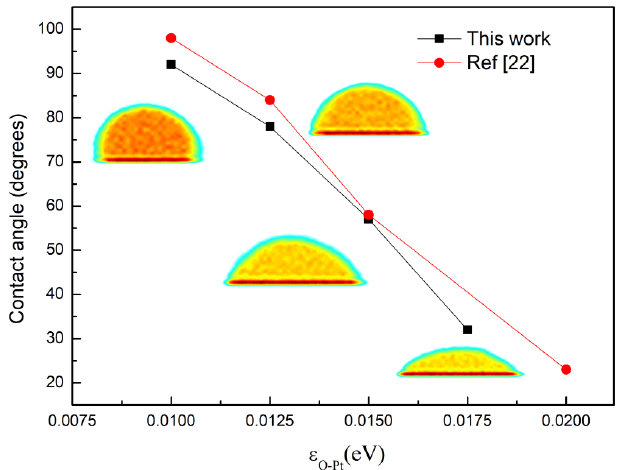
Figure 2. The contact angle of water droplets on surfaces with different wettability.